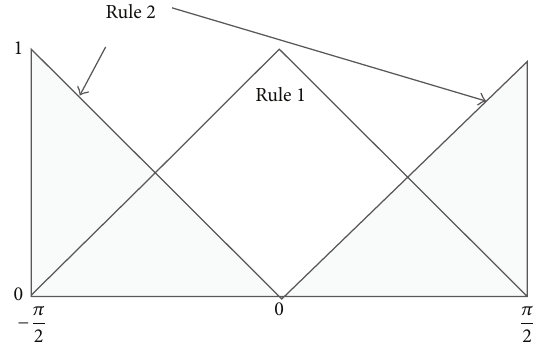
Figure 1: Membership functions of two-rule model.